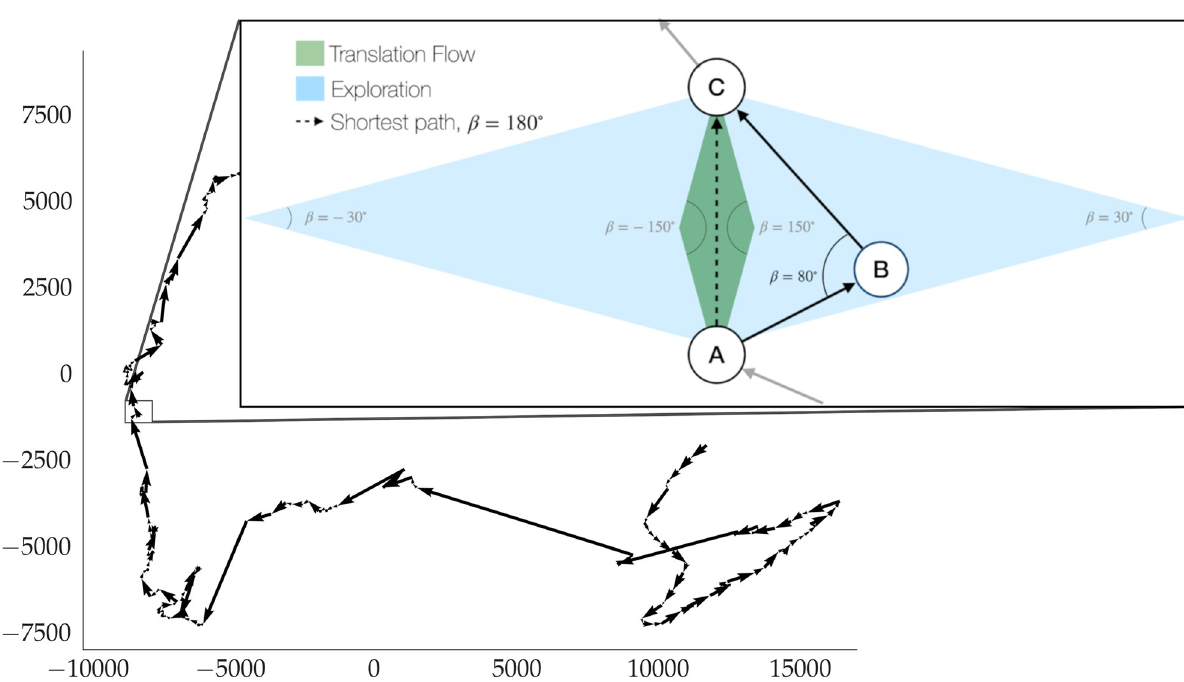
Fig 3. Trajectory of a draft. An illustration of the t SNE embedding of the draft versions for a single author in two dimensions. Distances in this space are the number of characters edited between one draft version and another. The set of arrows depicts the trajectory of the work on a single draft. The top right depiction shows an example section of the trajectory to display the vectors used in computing the Twist Ratio and the thresholds between exploration and translation flow.